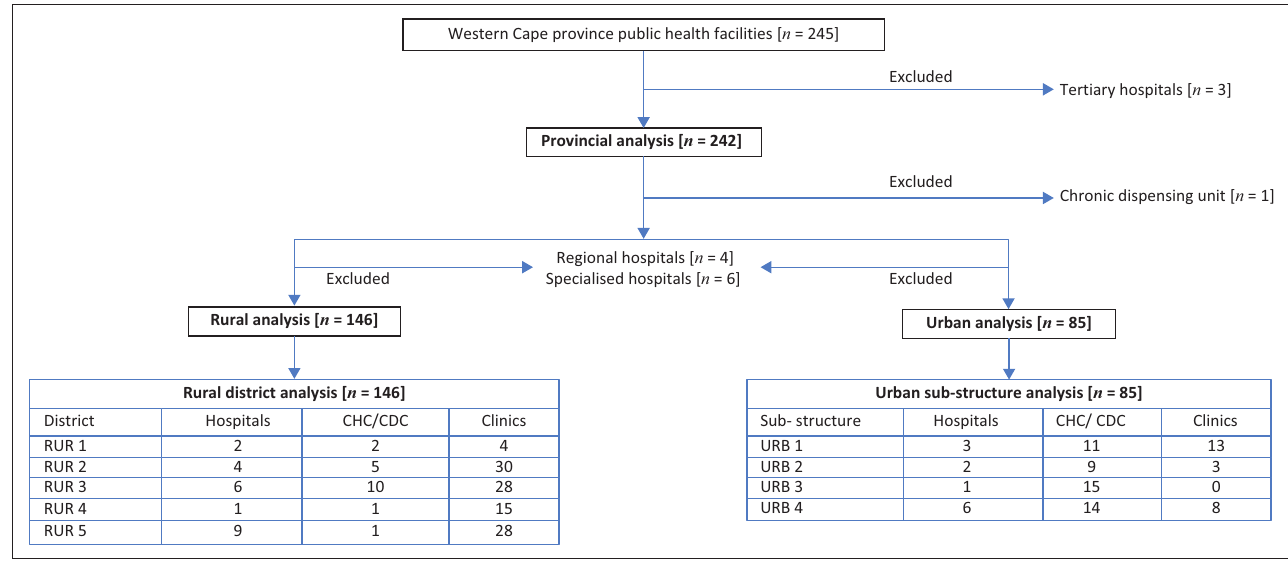
FIGURE 1: Illustration of the public healthcare facilities included in the consumption analyses of valproate, lamotrigine and